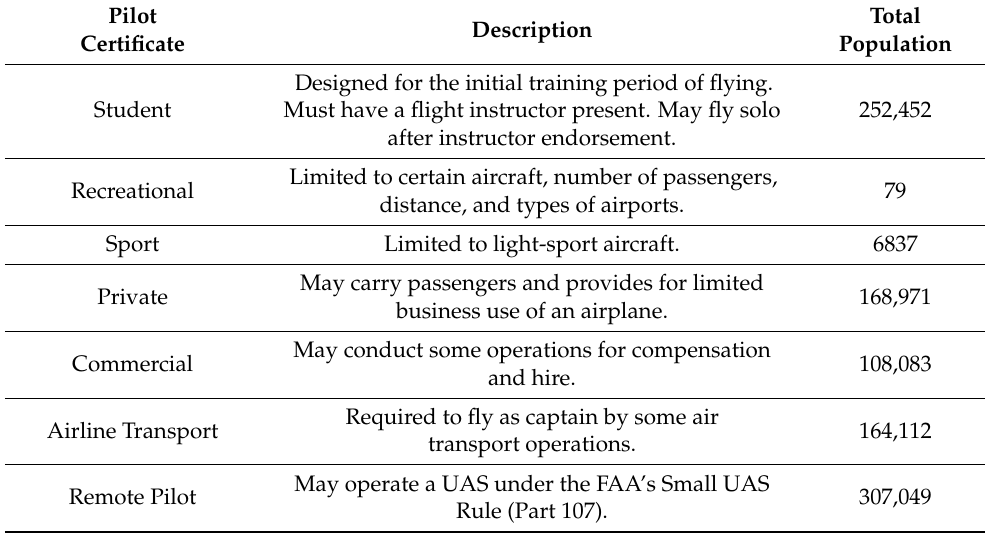
Table 1. Pilot Certification Population and